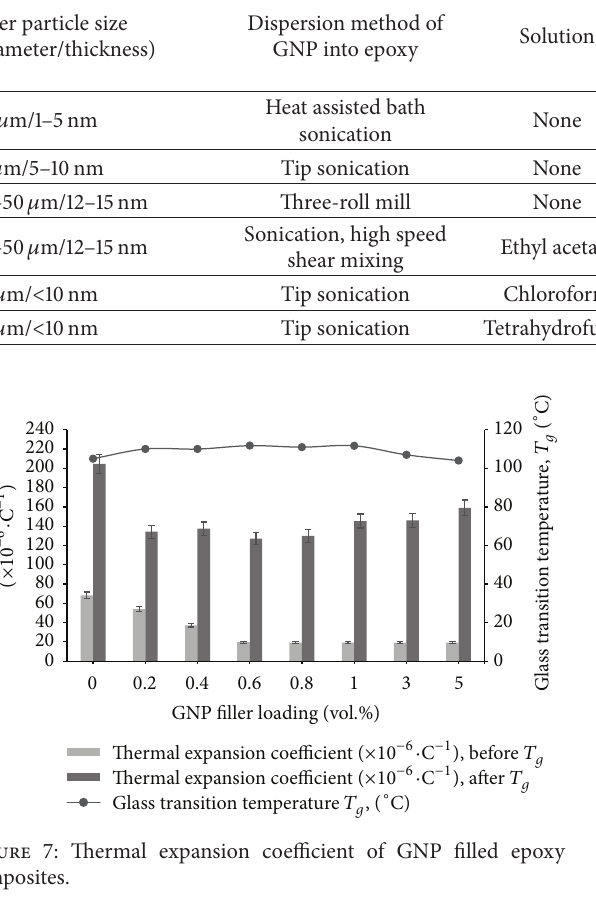
Table 1: Comparison study on the electrical conductivity of GNP filled epoxy system, with different particles size and dispersion method. Filler particle size